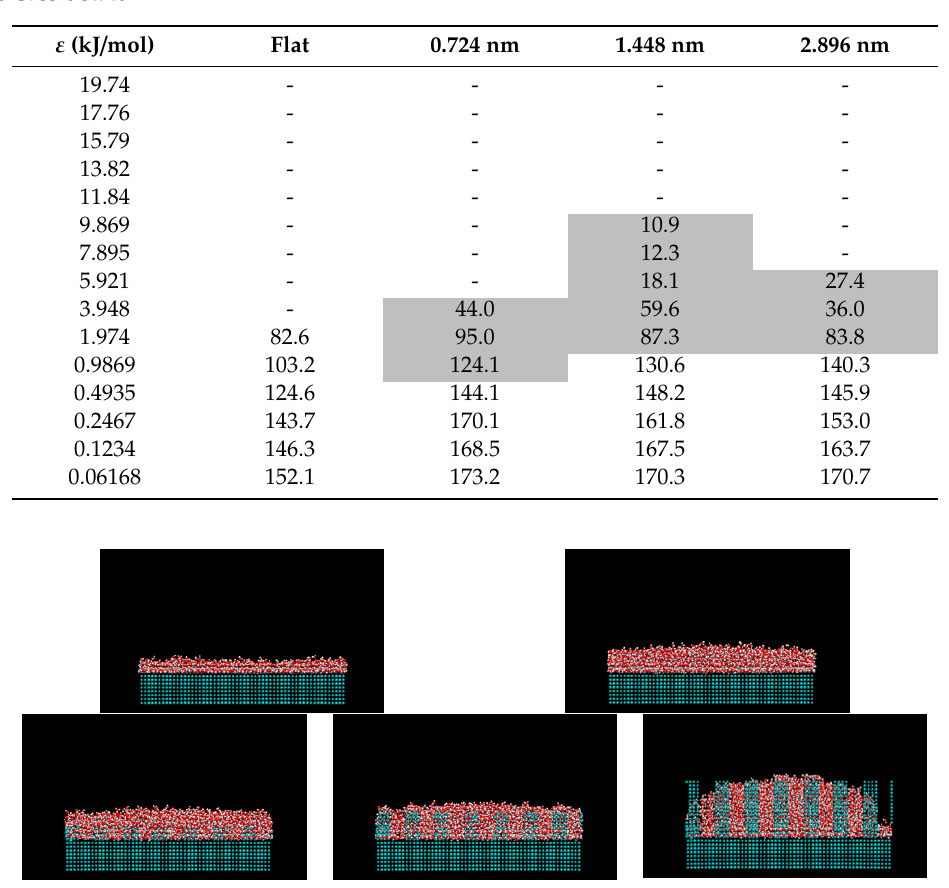
Figure 6. Snapshot of the water film on the flat and nanostructured surfaces with the Lennard-Jones parameter ε = 19.74 kJ/mol (the left upper: 2259 water molecules, others: 3787 water molecules).